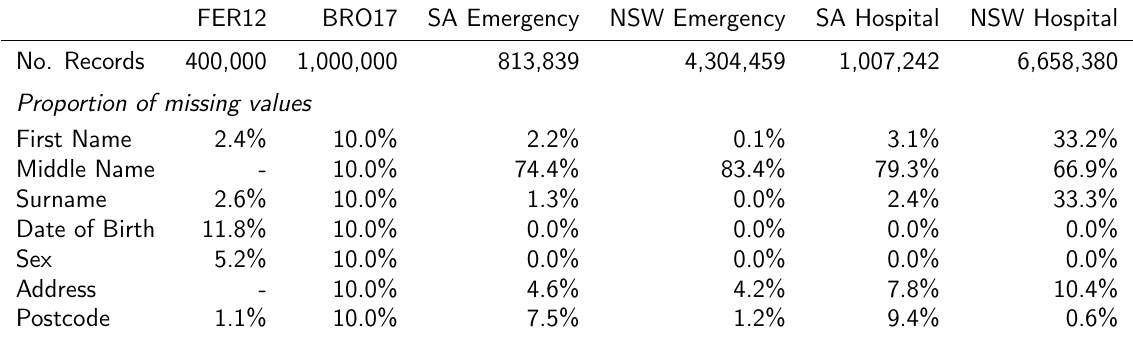
Table 3: Number of records and percentages of missing values for each